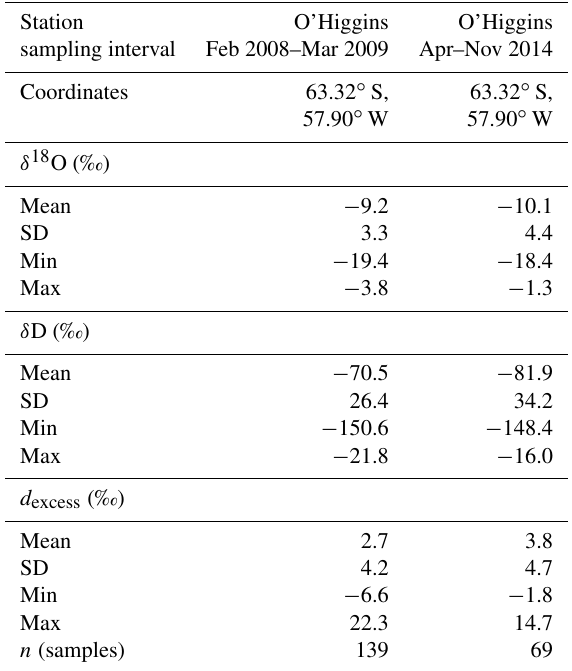
Table 2. Statistics of the stable water isotope composition of precip- itation samples collected at OH Station on the AP2008–2009 and 2014.